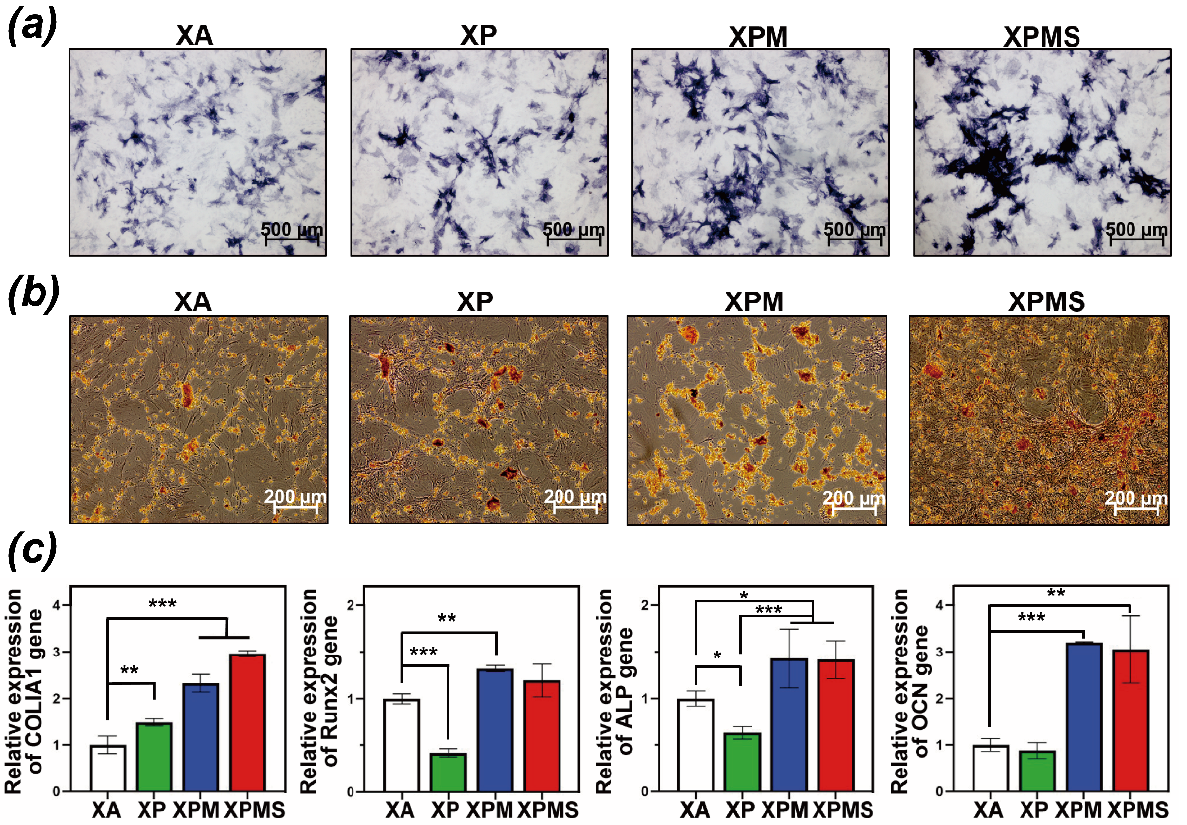
Figure 5. In vitro effect of XPMS hydrogel on BMSCs osteogenic differentiation ( a ) ALP staining of BMSCs cultivated by different hydrogel extractions; ( b ) ARS of BMSCs exposed to different hydrogel extractions; ( c ) relative mRNA expression of osteogenesis related genes (COL-I, Runx2, ALP and OCN) of BMSCs stimulated by different hydrogel extractions. * p < 0.05, ** p < 0.01, and *** p < 0.001.